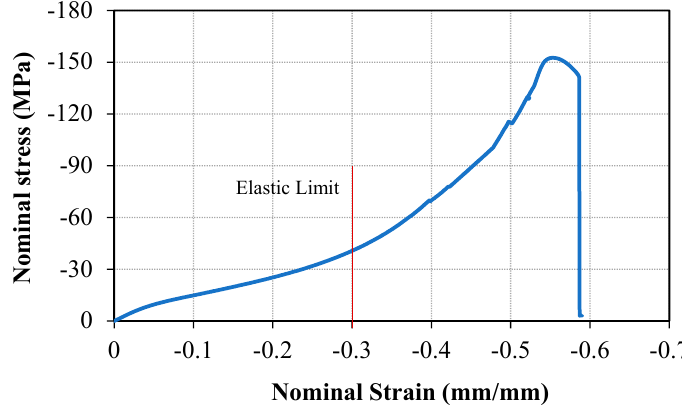
Figure 4. The mean values of nominal stress versus nominal strain obtained from the experimental results.